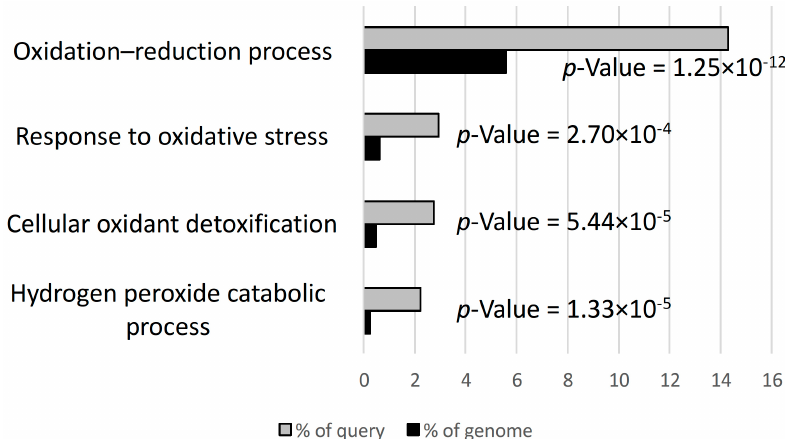
Figure 4. The four most highly significant gene ontology (GO) biological process parent terms resulting from a GO overrepresentation analysis of the D3 genes upregulated by inoculation treatment. Overrepresentation is shown by comparing genes in a given term as a percentage of the genome vs. as a percentage of the set of D3 upregulated genes.